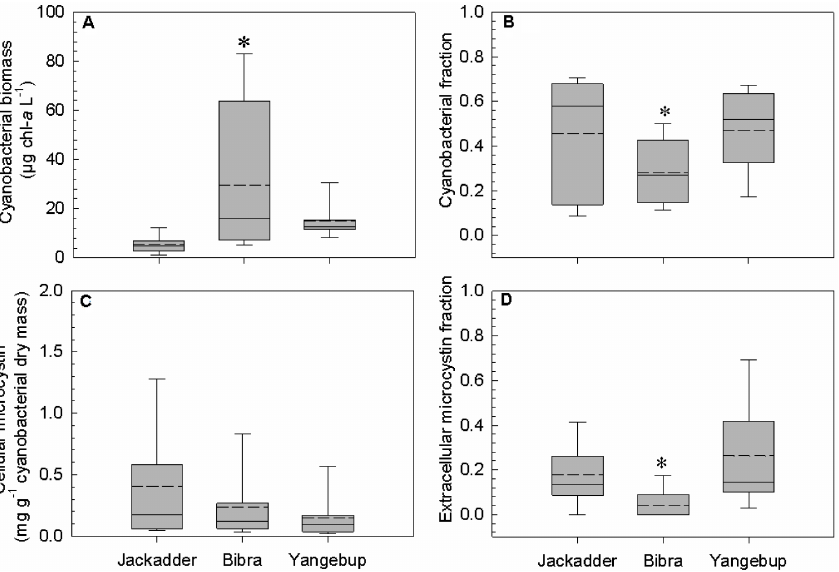
Figure 5. The variability of (a) cyanobacterial biomass (µgchl a L − 1 ), (b) cyanobacterial fraction (cyanobacterial biomass to total biomass), (c) cellular microcystin concentration (mgg − 1 cyanobacterial dry mass) and (d) extracellular microcystin fraction over time for each lake. Boxes represent 25th to 75th percentiles; straight lines within the boxes mark the median, short dashed lines the mean; whiskers below and above the boxes indicate 10th and 90th percentiles. Asterisks ( ∗ ) indicate lakes that are significantly ( p < 0.05) different from other